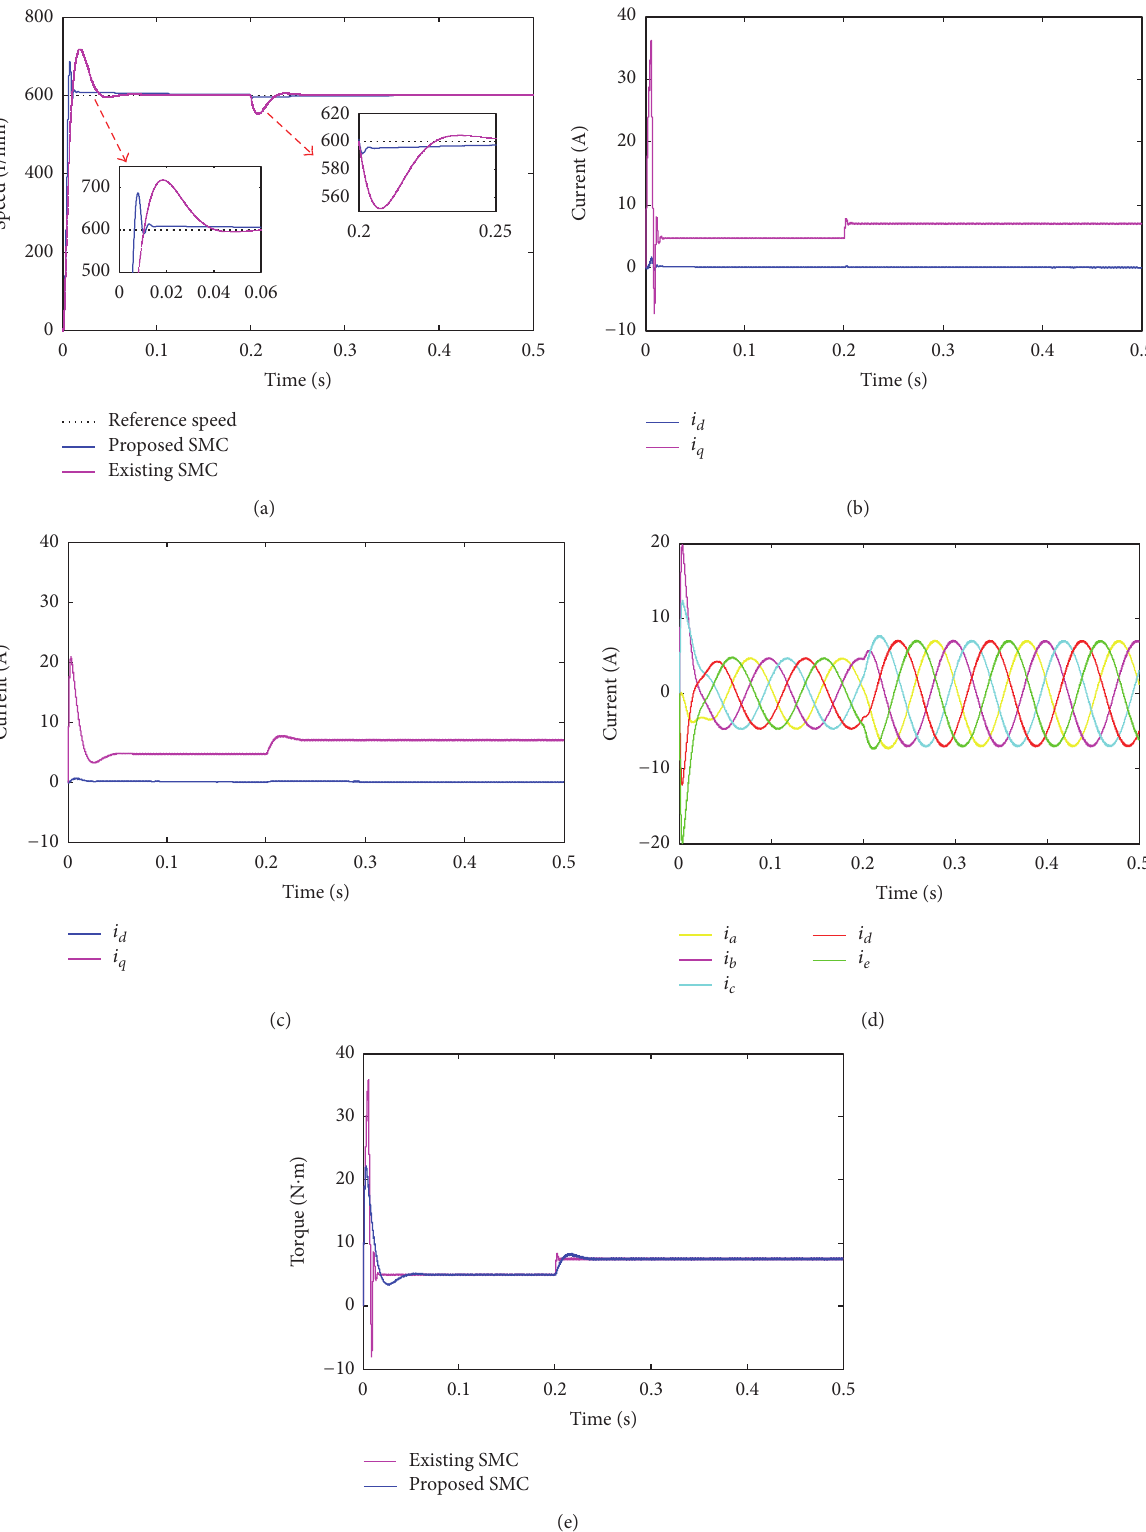
Figure 6: Simulation results when increasing load from 5N ⋅ m to 7.5 N ⋅ m. (a) Speed response. (b) Current waveforms 𝑖 𝑑 and 𝑖 𝑞 under the existing SMC. (c) Current waveforms 𝑖 𝑑 and 𝑖 𝑞 under the proposed SMC. (d) Waveforms of the five-phase currents. (e) Torque